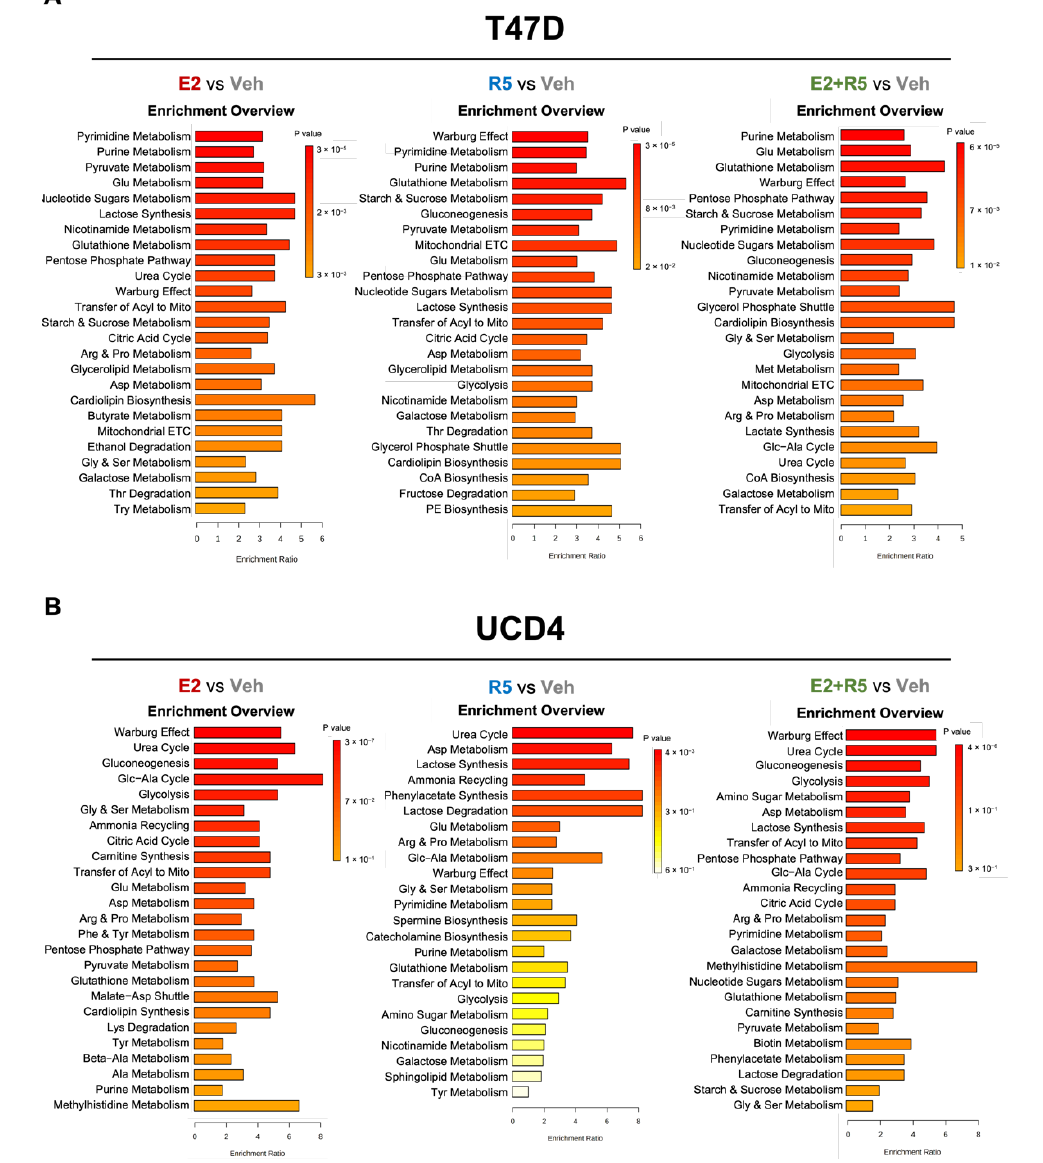
Figure 2. Estrogens and progestins enrich metabolites associated with glucose metabolism and fatty acid metabolism. Metabolite enrichment analysis of T47D ( A ) and UCD4 ( B ) metabolomics samples for each hormone treatment using a positive 1.2−fold change cutoff from vehicle. Bar charts generated using enrichment over representation analysis feature and SMPDB metabolite database on MetaboAnalyst. Enrichment ratio is calculated by the proportion of observed hits to expected hits. Enrichment scores and p -values are given in Supplementary Table